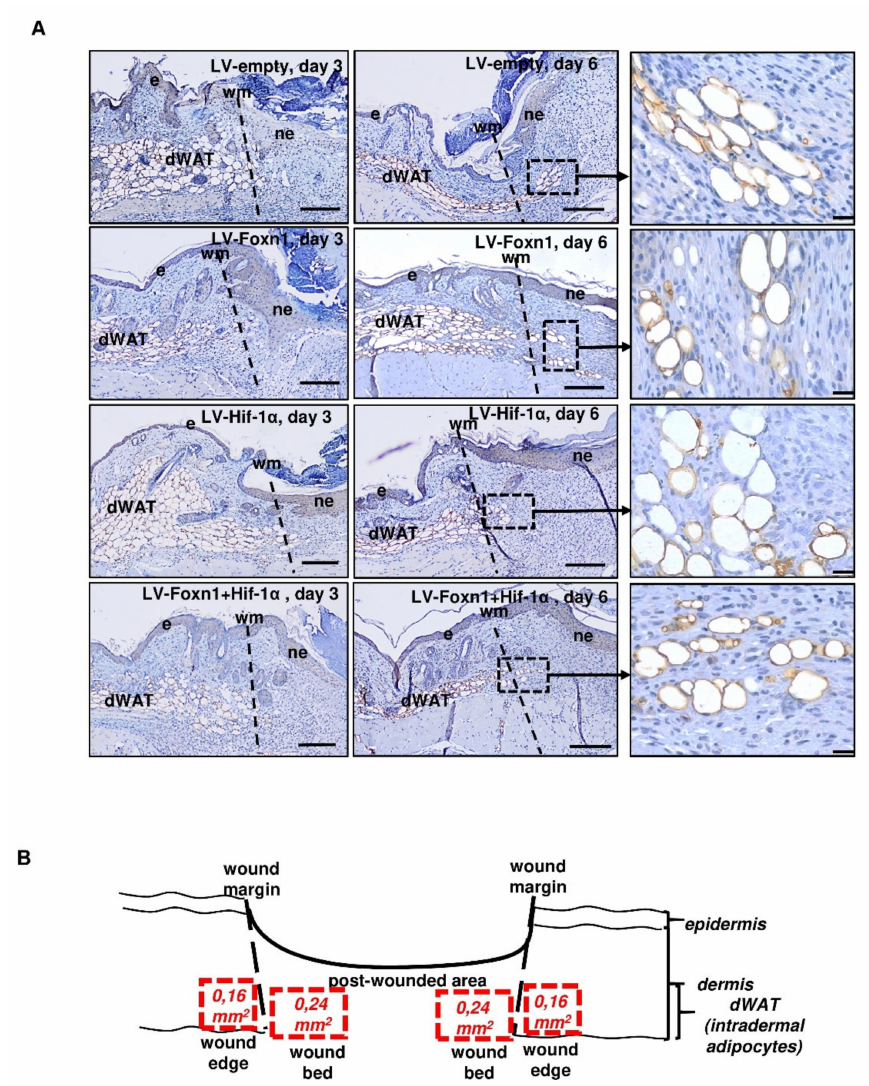
Figure 4. Immunohistochemical detection of perilipin 1 ( A ) as a marker of dWAT presence at the wound edge and wound bed ( B ) in LV-empty-, LV-Hif-1 α -, LV-Foxn1- or LV-Hif-1 α +LV-Foxn1-injected mice analyzed on days 3 and 6, post-wounding ( n = 3–4 mice per group/per day). ( B ) the scheme indicates the area (red squares) of wound edge and wound bed of perillipin 1 positive dWAT analysis; e—epidermis, ne—neo-epidermis, wm—wound margin, and dWAT—dermal white adipose tissue, scale bar ( A ) 100 µ m, inset 20 µ